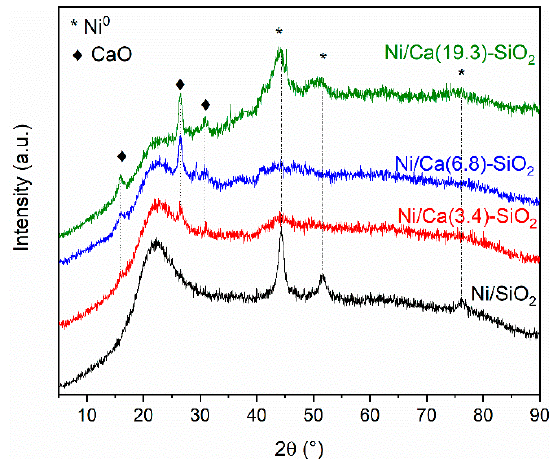
Figure 11. X-ray diffractograms of used Ni/SiO 2 and Ni/Ca(X)-SiO 2 catalysts.